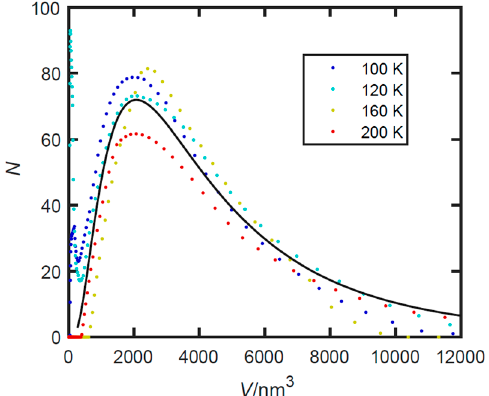
Figure 8. Particle volume distribution obtained using MINORIM software by inversion method analysis of magnetization loops. Profiles obtained from analysis of data collected in a wide temperature range (dots) were fitted with unique log-normal distribution function (solid line).